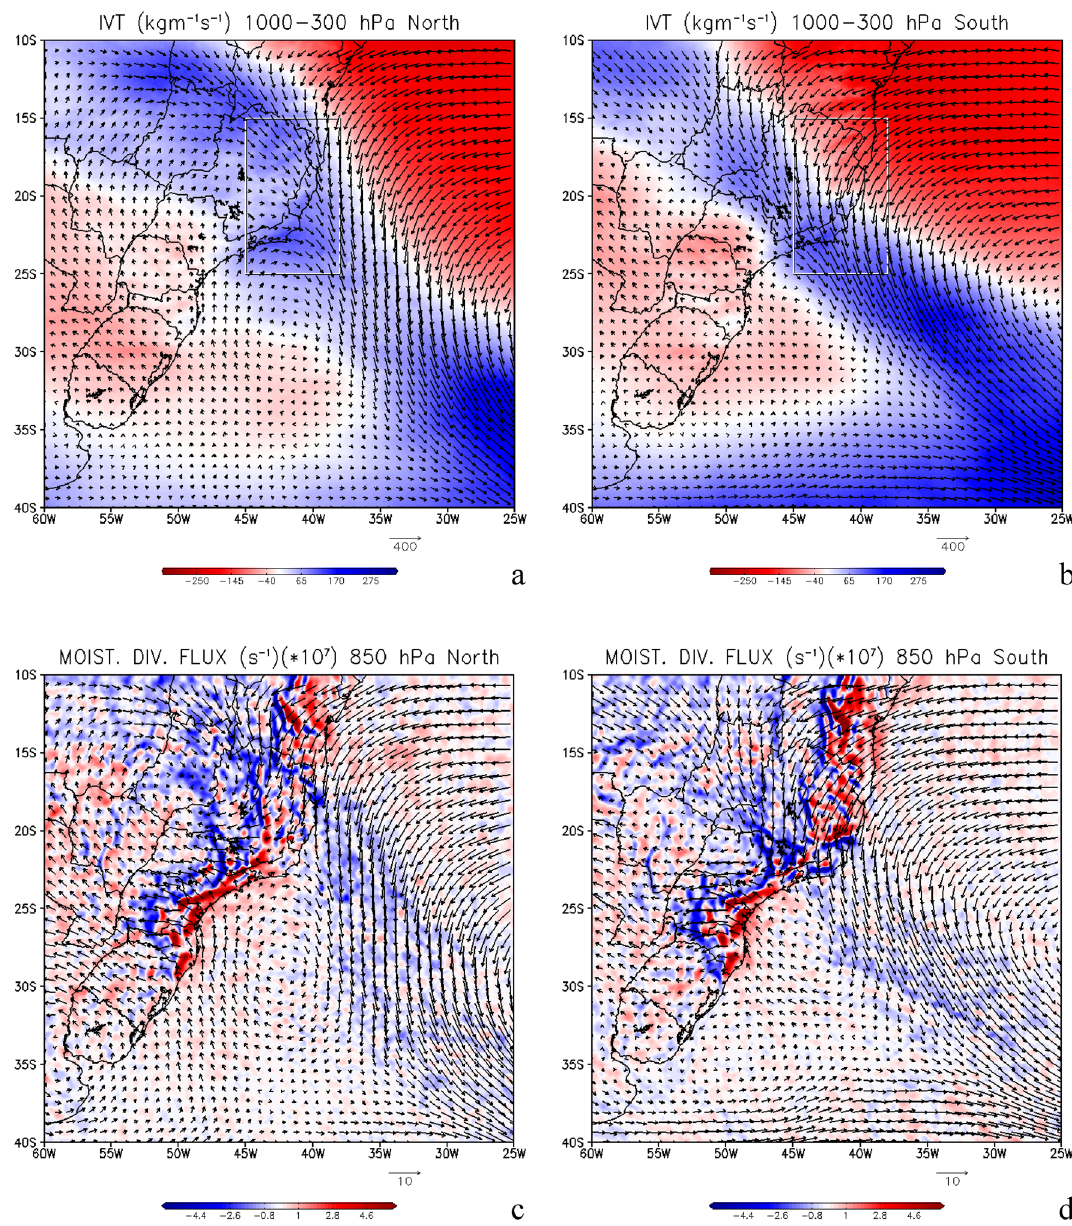
Figure 4. Integrated vapor transport (IVT) from 1000 to 300 hPa for the three cases where the oceanic South Atlantic Convergence Zone (SACZ) were anchored further north ( a ) and for the four oceanic SACZ cases when they were anchored further south ( b ), in kg m −1 s −1 . Moisture divergence flux (shaded) and zonal moisture flux transport (vectors) for the north cases ( c ) and south cases ( d ), in 1 × 10 7 s −1 . Precipitable water (PW) vapor from 1000 to 300 hPa for the three cases where the oceanic SACZ were anchored further north ( e ), for the four oceanic SACZ cases where they were anchored further south ( f,g ) for all the seven cases, in mm day −1 . The red lines represent the areas where the precipitable water was averaged and presented in Table 4. The continental area is over the continent, the oceanic area is over the ocean. The total area considers both areas. Grid Analysis and Display System (GrADS), Version 2.2.1.oga.1. http:// openg rads.